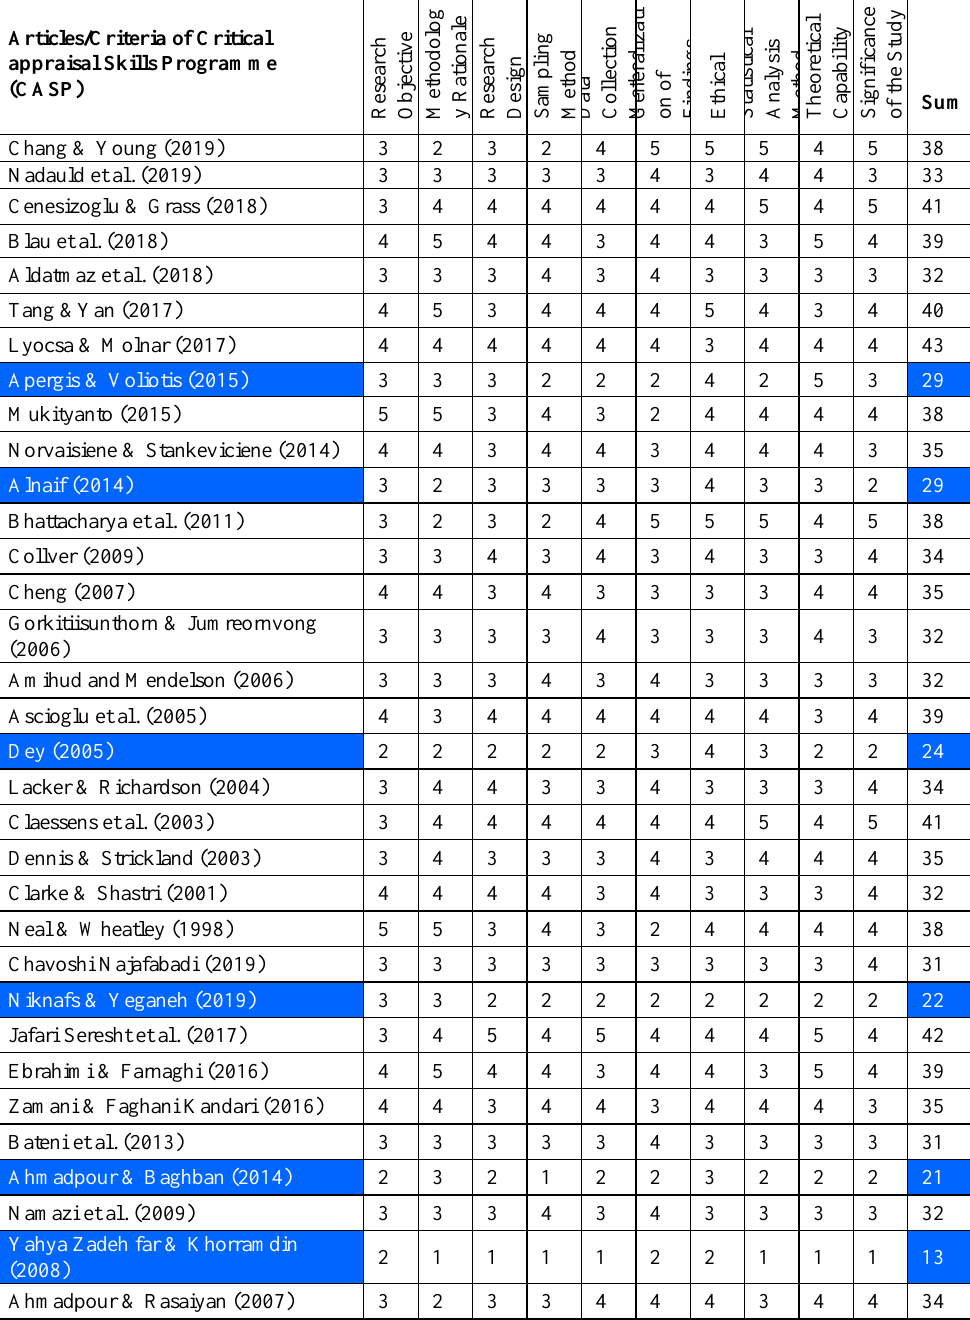
Table 2. Critical appraisal Skills Programmer (CASP) of Research